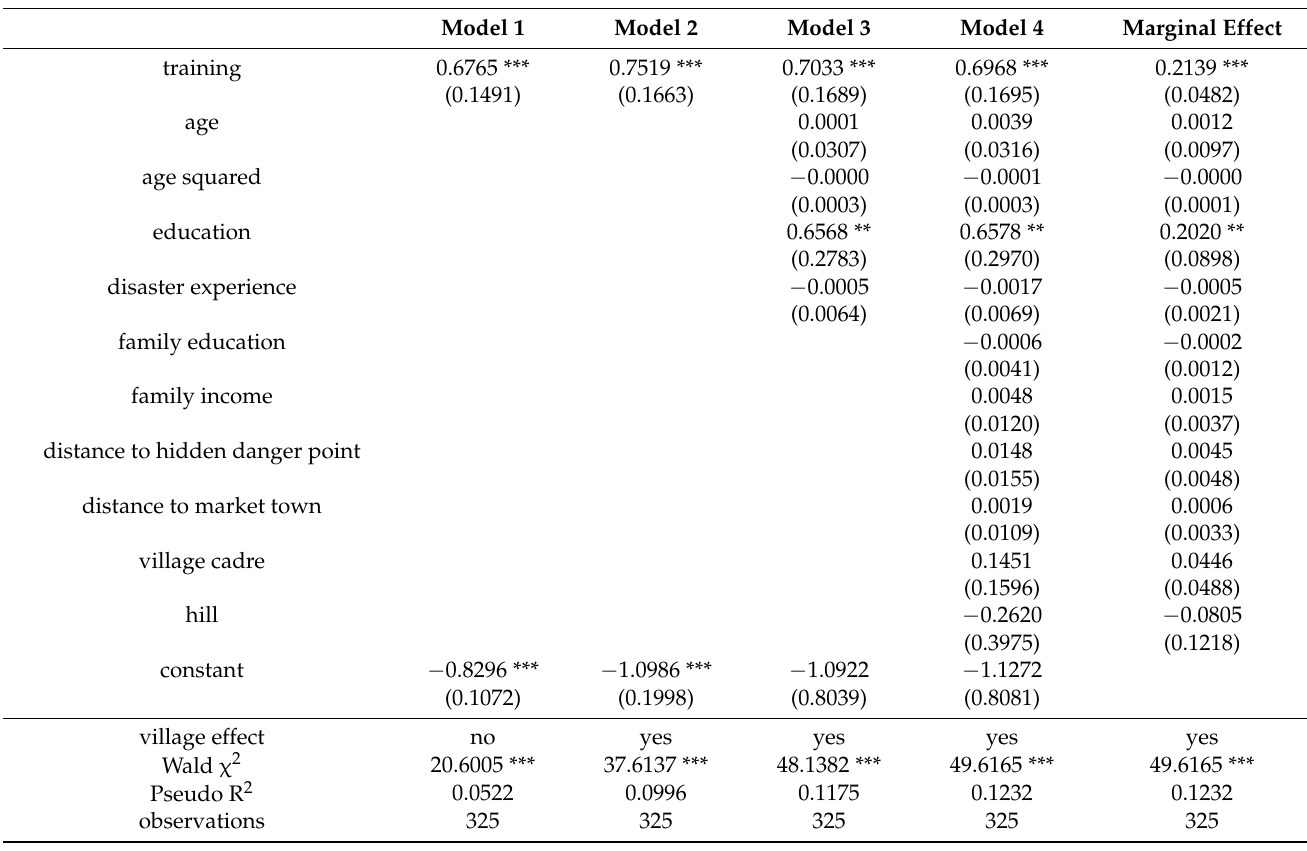
Table 2. The impact of training on the possibility of farmers’ earthquake